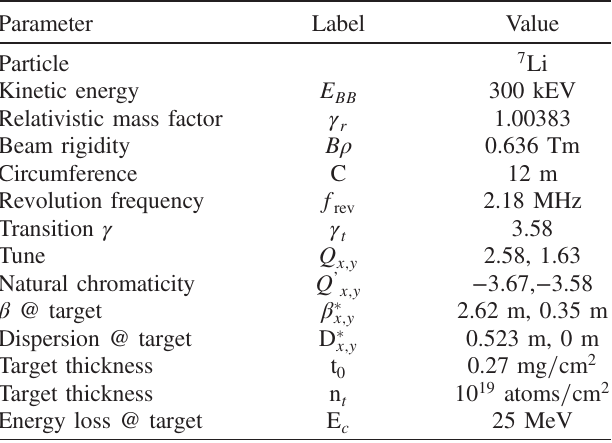
TABLE II. Beta-beam requirements for the production